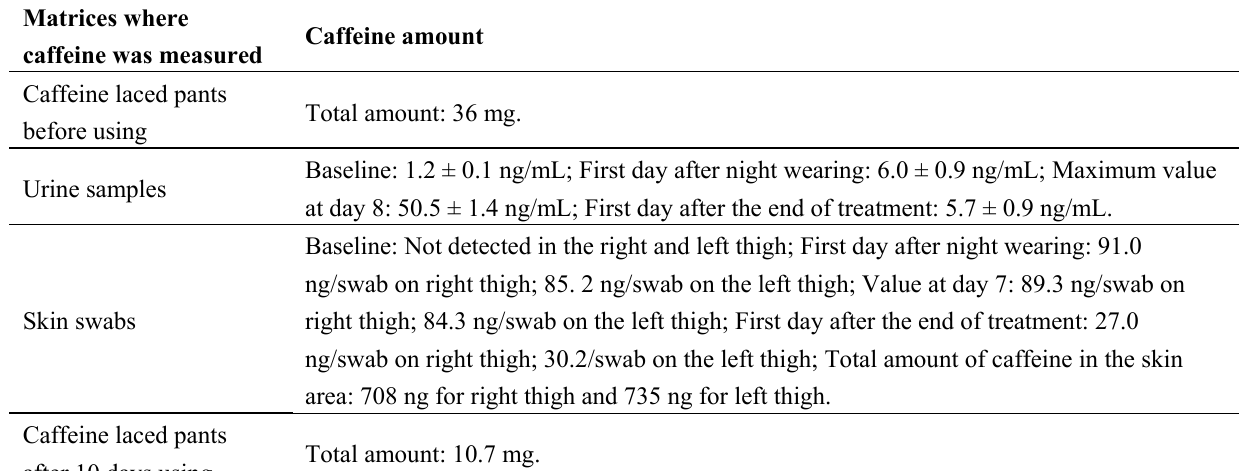
Table 3. Amount of caffeine present in laced pants before and after using, in urine samples at baseline and during the wearing, in the skin swabs collected during wearing and in the skin